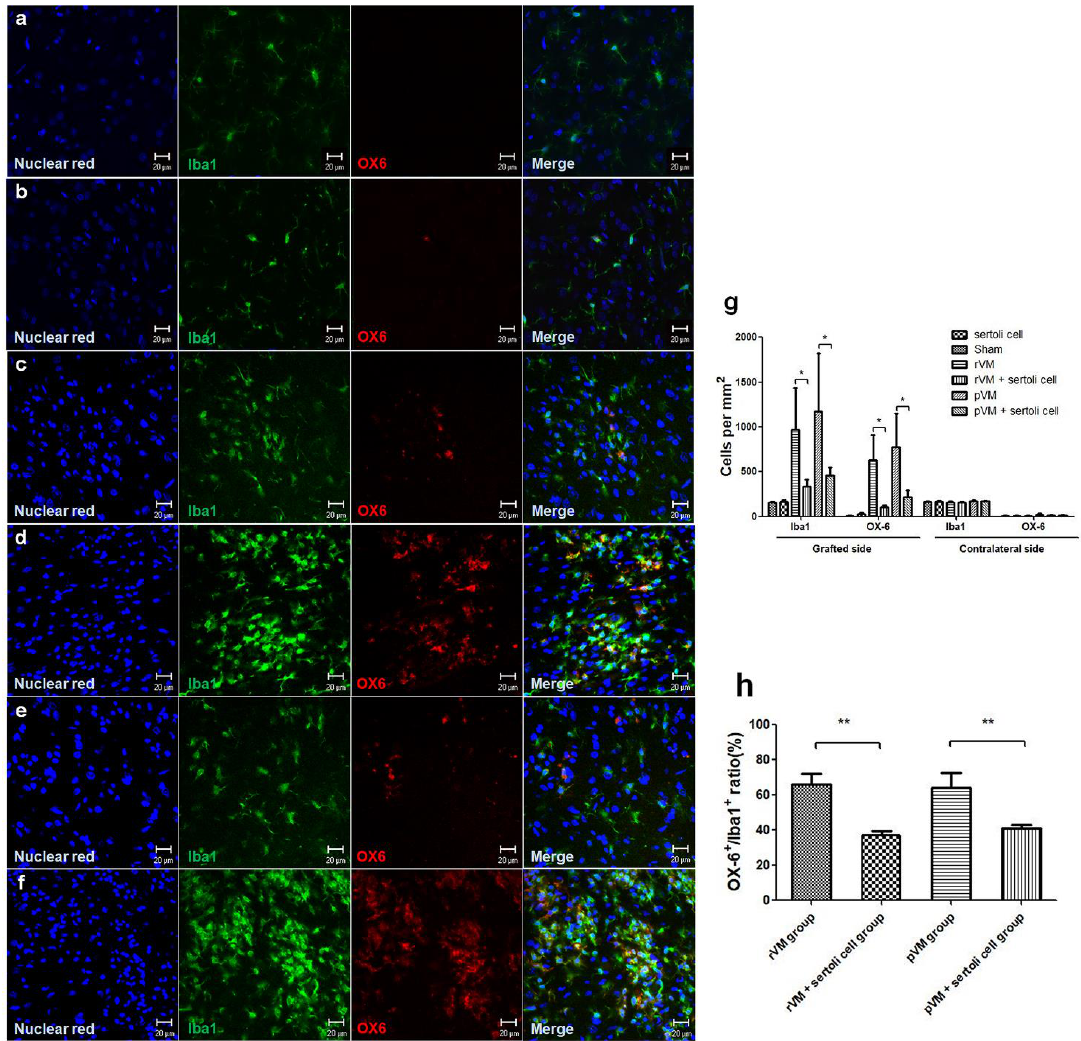
Figure 9. Immunofluorescence staining with anti-Iba1 and anti-OX6 antibody and quantification results at four weeks after transplantation. A severe immune response in grafted striatum was noted in the rVM group and pVM group. Co-grafted groups showed lower microglia cell numbers compared with the rVM and pVM groups. Quantification results showed that Iba1-ir and OX6-ir were obviously increased in the rVM and pVM groups. The OX-6 +/ Iba1 + ratio was lower in the rVM + SCs and pVM + SCs groups than in the rVM and pVM groups. ( a ) Sham group. ( b ) SCs group. ( c ) rVM group. ( d ) rVM + SCs group. ( e ) pVM group. ( f ) pVM + SCs group. ( g ) Quantification of Iba1-ir and OX-6-ir cell numbers. ( h